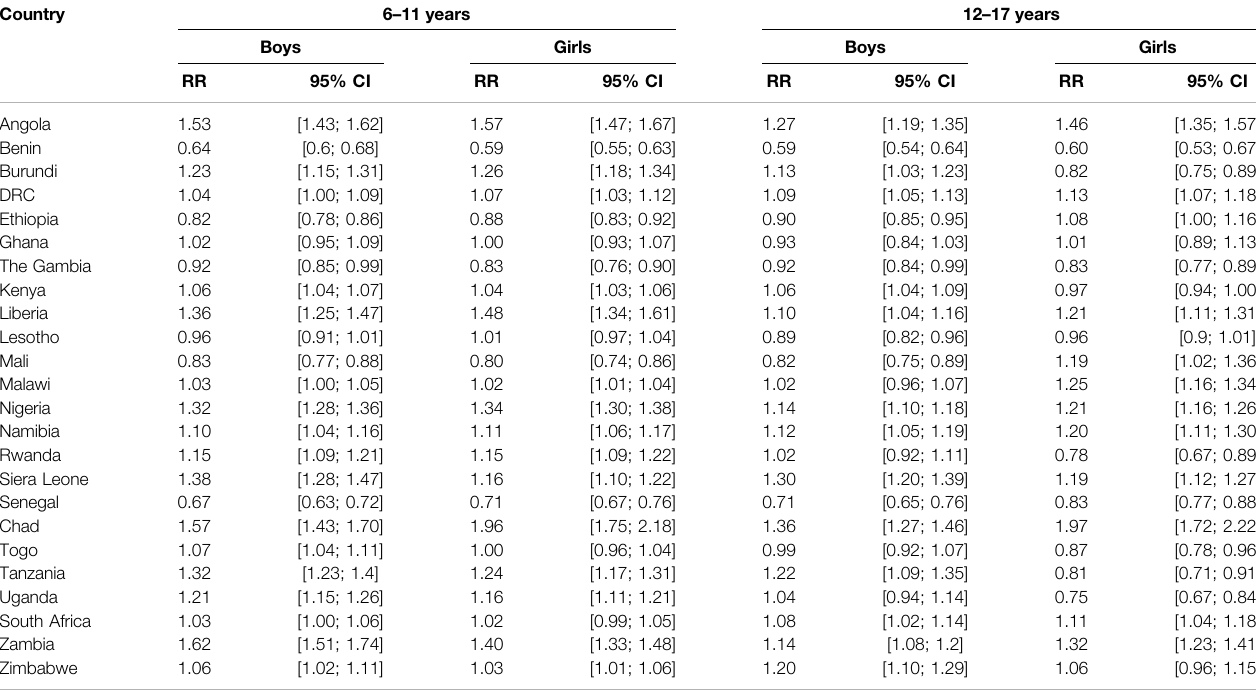
TABLE 4 | Rate ratio in school enrolment by age group and gender. Country